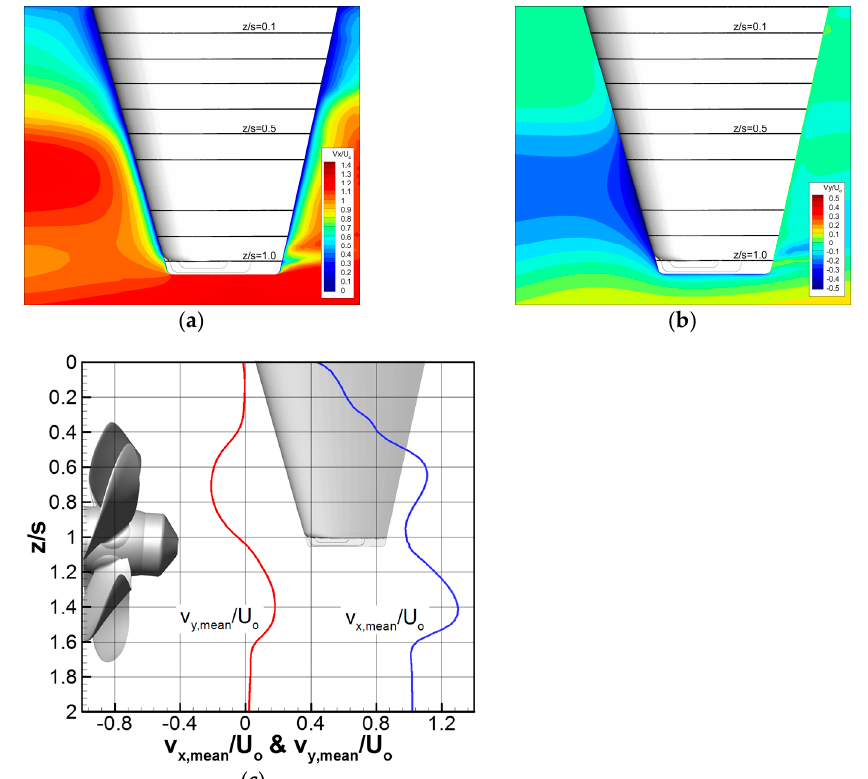
the port side flat rudder at δ R = 0°and 26 knot ship speed: ( a ) axial velocity distribution; ( b ) transverse velocity distribution.